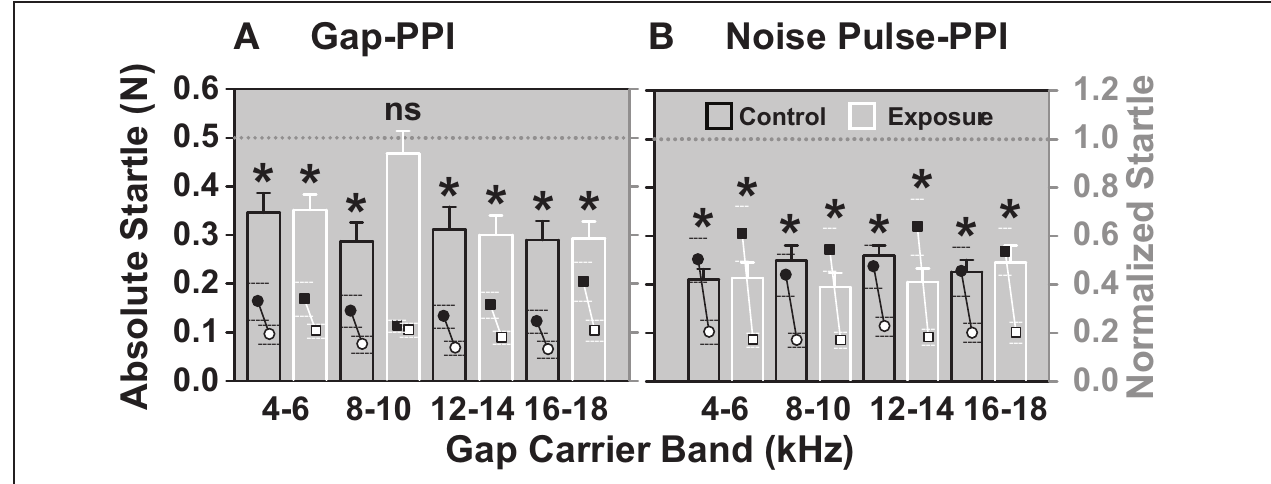
for the four different gap-carrier/noise pulse bands. Normalized startle responses were derived from the mean of all trials of one animal for one day with the gap normalized to the mean of all trials of one animal of one day without the gap. ∗ Indicates significance in Two-Way repeated measures ANOVA ( p < 0 .